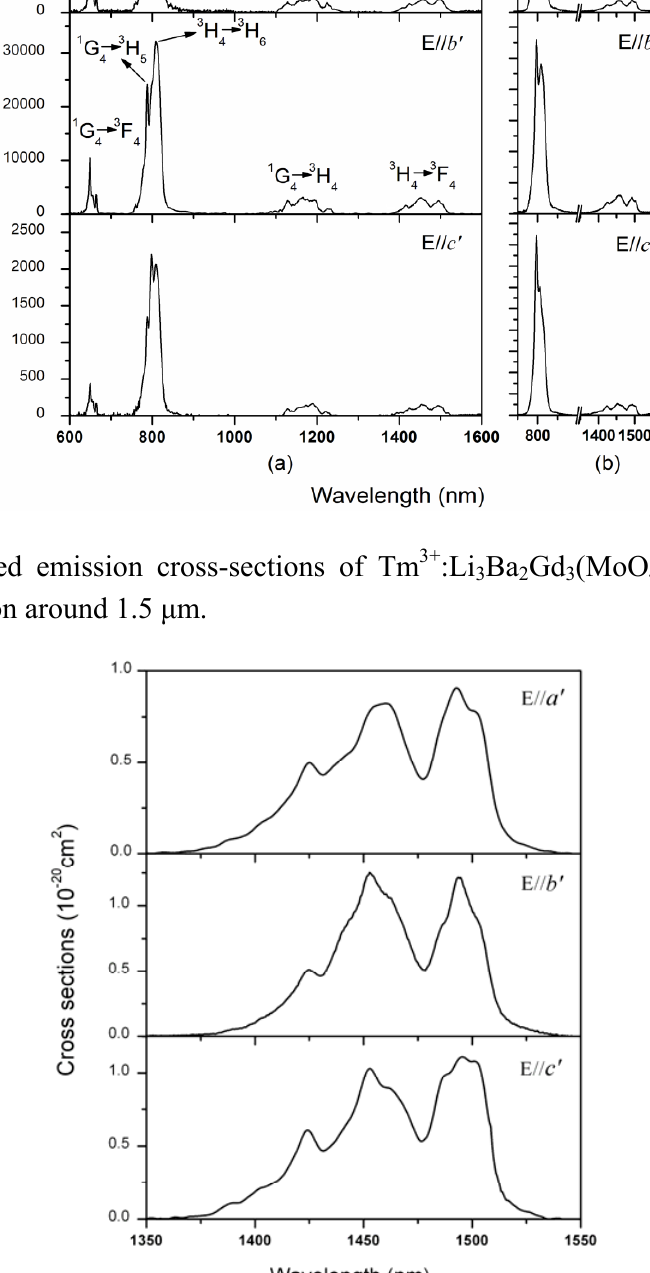
Figure 3. Polarized fluorescence spectra of Tm 3+ :Li with 473 radiation; ( b ) Excited with 688 nm radiation.